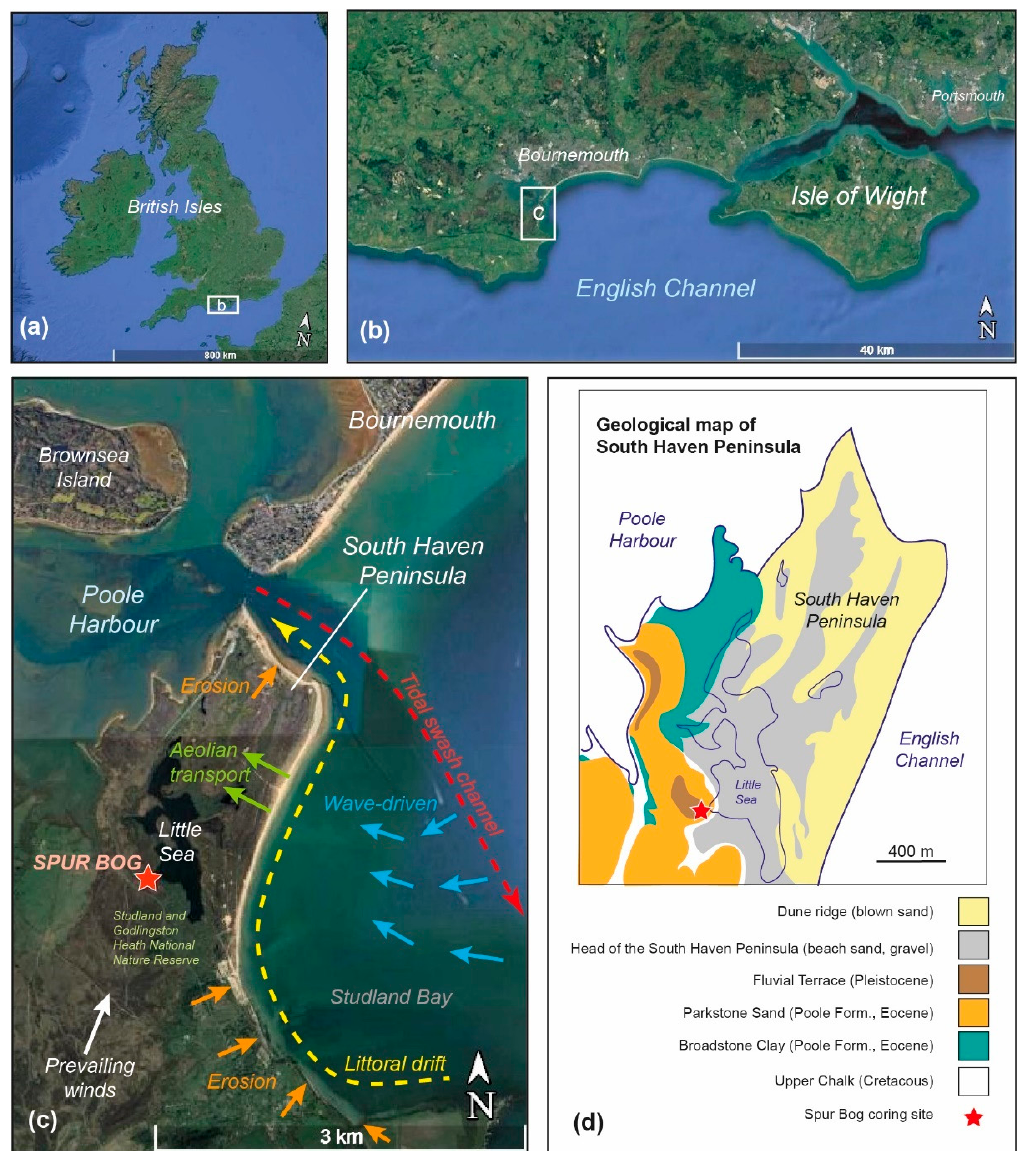
Figure 1. ( a , b ) Google Earth (2021) satellite images showing the study area in southern England. ( c ) Aerial image (Google Earth, 2021) of the South Haven Peninsula with the coring location at Spur Bog (red star). Coloured arrows indicate the main sediment transport processes in Studland Bay, based on the SCOPAC Sediment Transport Study [16], modified from [11]. ( d ) Geological map of South Haven Peninsula (modified from [14]).